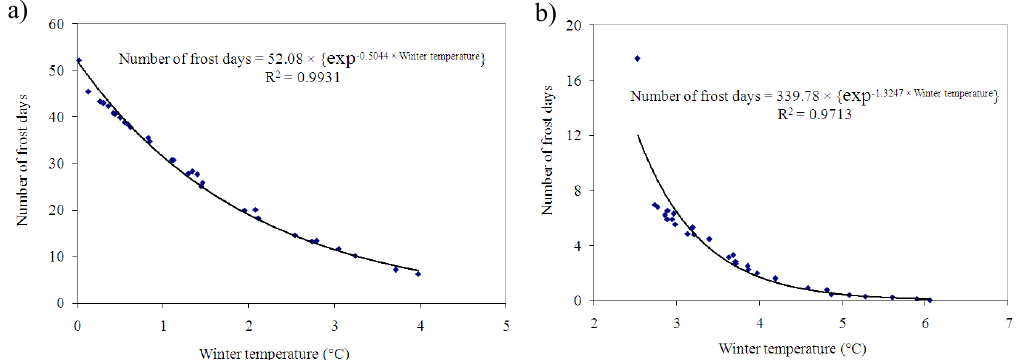
Fig. 7. The change in number of frost days with daily average winter temperature (a) at the Forni Avoltri station and (b) at the Cedarchis station. Each data point in the graph represents the number of frost days predicted by a certain scenario within a certain time period.